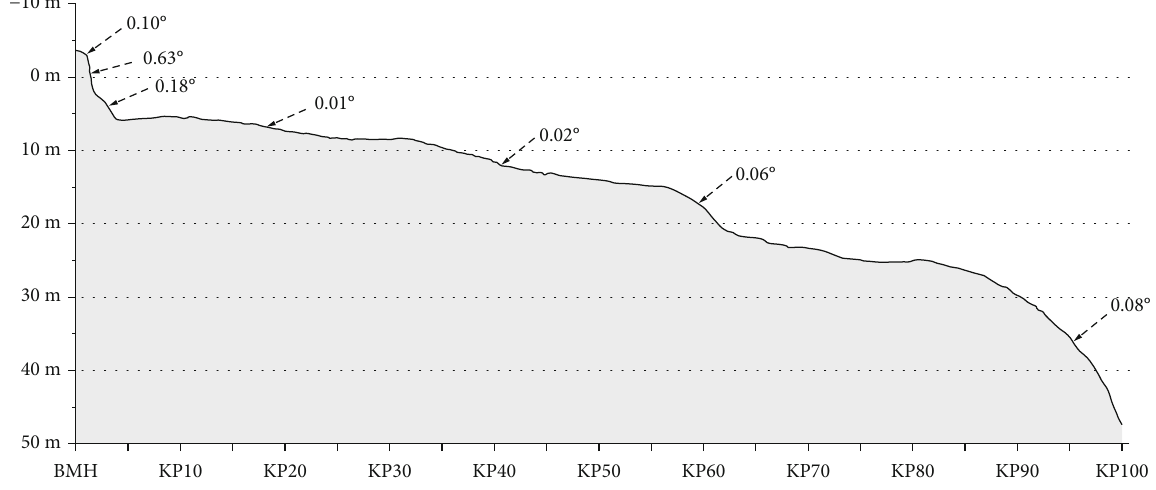
Figure 3: Routing topographic pro fi le (submerged delta portion of the Yangtze